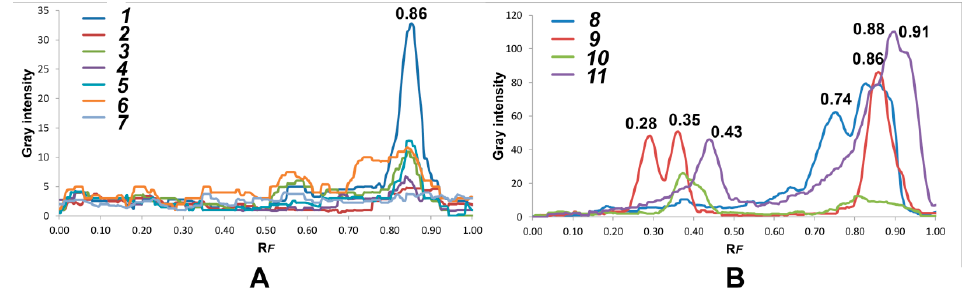
Figure 1. Line profiles of investigated wood extracts based on HPTLC analysis: ( A ) oak samples (no. 1–7); ( B ) non-oak samples (no. 8–11): black locust ( Robinia pseudoacacia L.) (no. 8), myrobalan plum ( Prunus cerasifera Ehrh.) (no. 9), wild cherry ( Prunus avium L.) (no. 10) and mulberry ( Morus alba L.) (no 11).